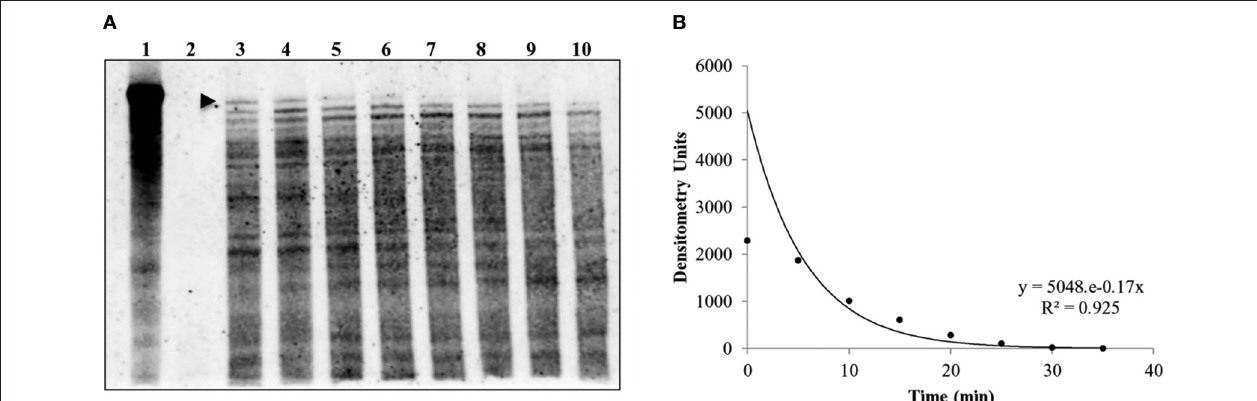
FIGURE 8 | Half-life of C. burnetii ’s IVS RNA in E. coli (IRW205). A representative RPA used to determine the in vivo IVS half-life is shown. (A) RPA blot with IVS band (480 bases) indicated by an arrowhead (3 µ g RNA per lane and 800 pg of IVS probe were used). Lanes 1 and 2 show controls with biotin-labeled IVS probe in the absence or presence of RNase A/T1, respectively; Lanes 3–10 show RNA isolated at 5-min intervals from 0 to 35min following rifampin treatment. (B) Densitometric analysis of IVS bands in blot lanes 3–10 vs. time of collection following rifampin treatment. The equation for the exponential curve and the R 2 value are inset and yield an IVS half-life of 3.9min.